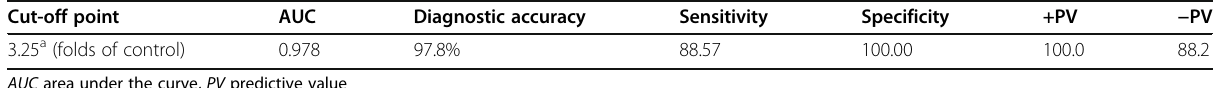
Table 7 Diagnostic performance of HOTAIR expression in AML patients Cut-off point